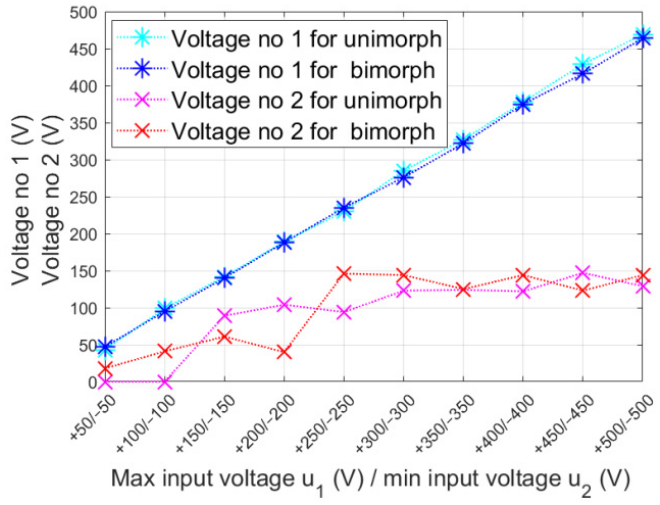
Figure 13. Comparison of characteristic input voltages between unimorph and bimorph.